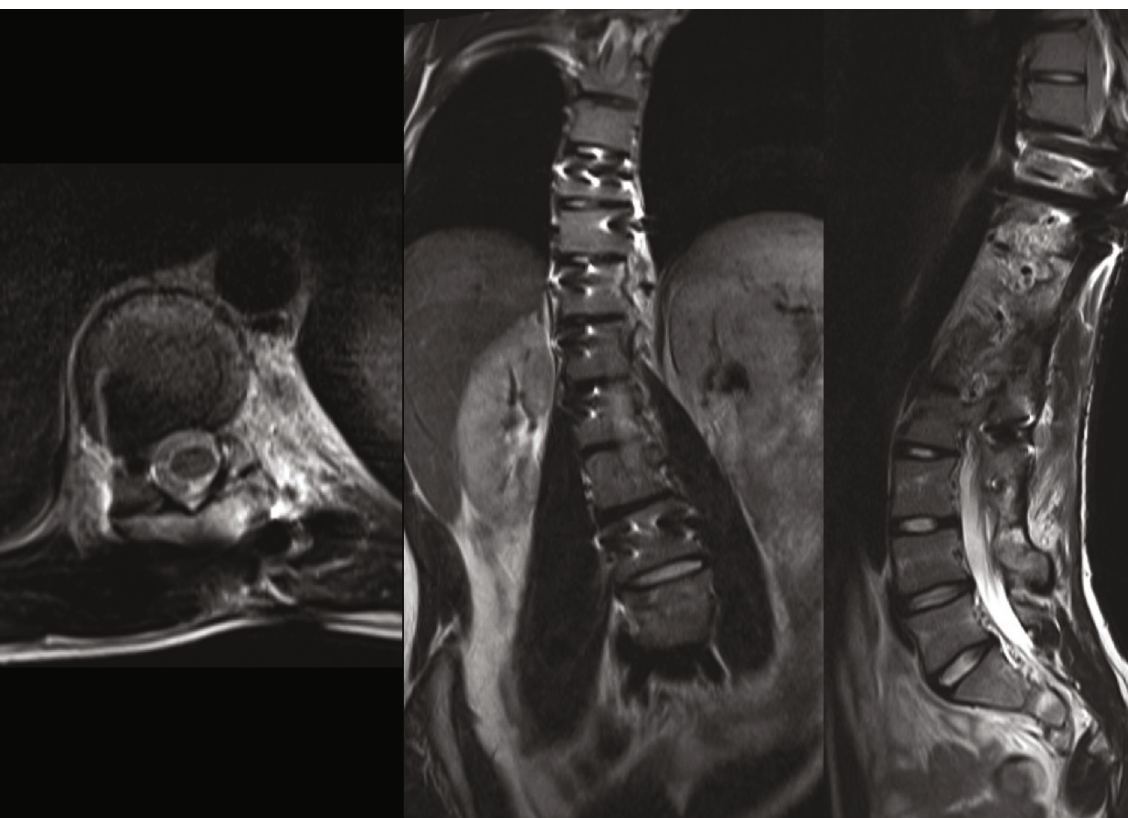
Figure 7: MRI scan at the follow-up visit to outpatient clinic, at July 30 th , 2018, 2 years and 7 months are passed since the surgery. No tumor growth was detected on the follow-up scan. (a) Axial view at the T11 vertebral body level. The tumor is still con fi ned to pedicle and left paravertebral muscular area. (b) Coronal view. The tumor is still located along the left sides of T10 – T12 vertebrae. (c) Sagittal view.